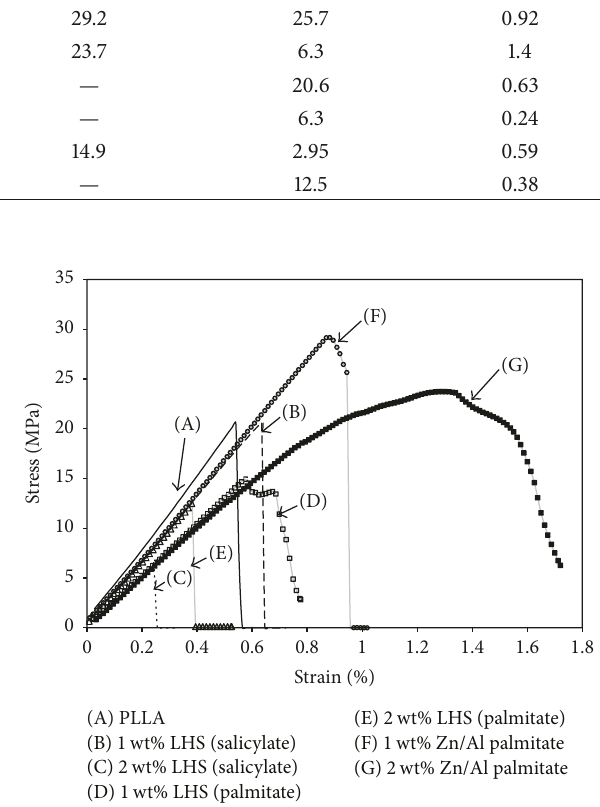
Figure 10: Stress versus strain curves derived from flexure tests to PLLA (A) and PLLA nanocomposites